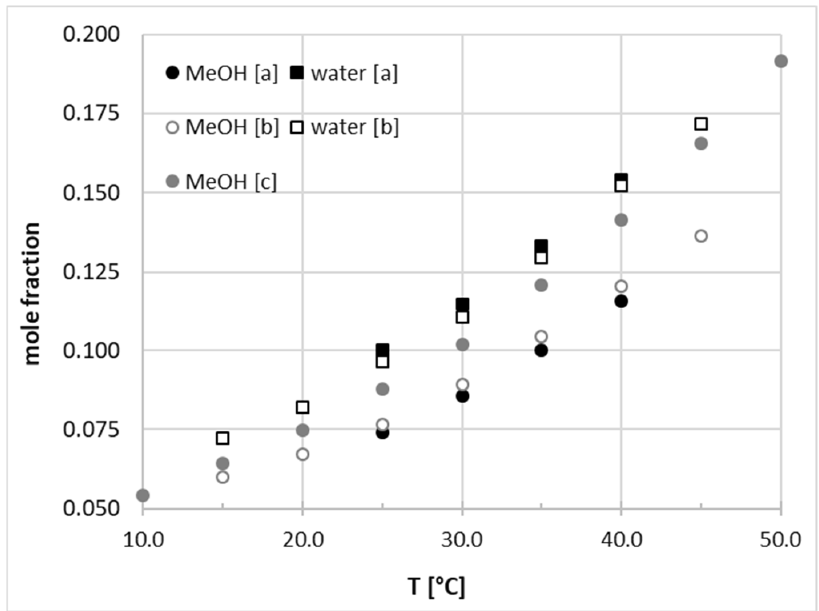
Figure 3. Solubility of nicotinamide in pure methanol and water estimated by this work (a) and according to ref. [17] (dataset (b)) and ref [19] (dataset (c)). Table 2. Measured values of nicotinamide mole fraction (10 3 ) in saturated solution of neat solvents. Ideal solubility was estimated using Equation (1) and DSC data provided herein.